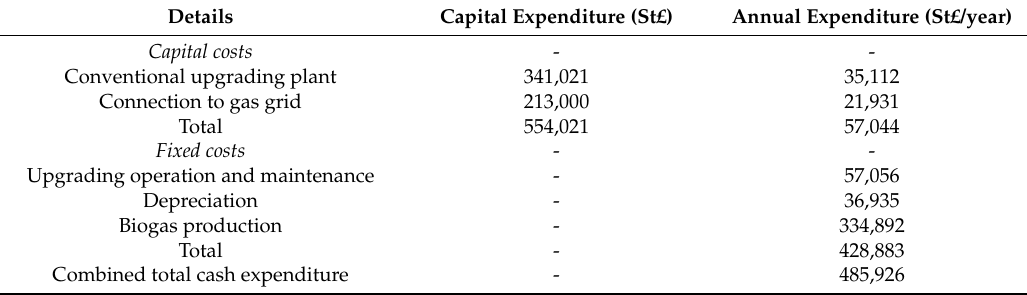
Table A3. Expenditure for conventional upgrading of biogas for use as CNG (routes T2/H2).